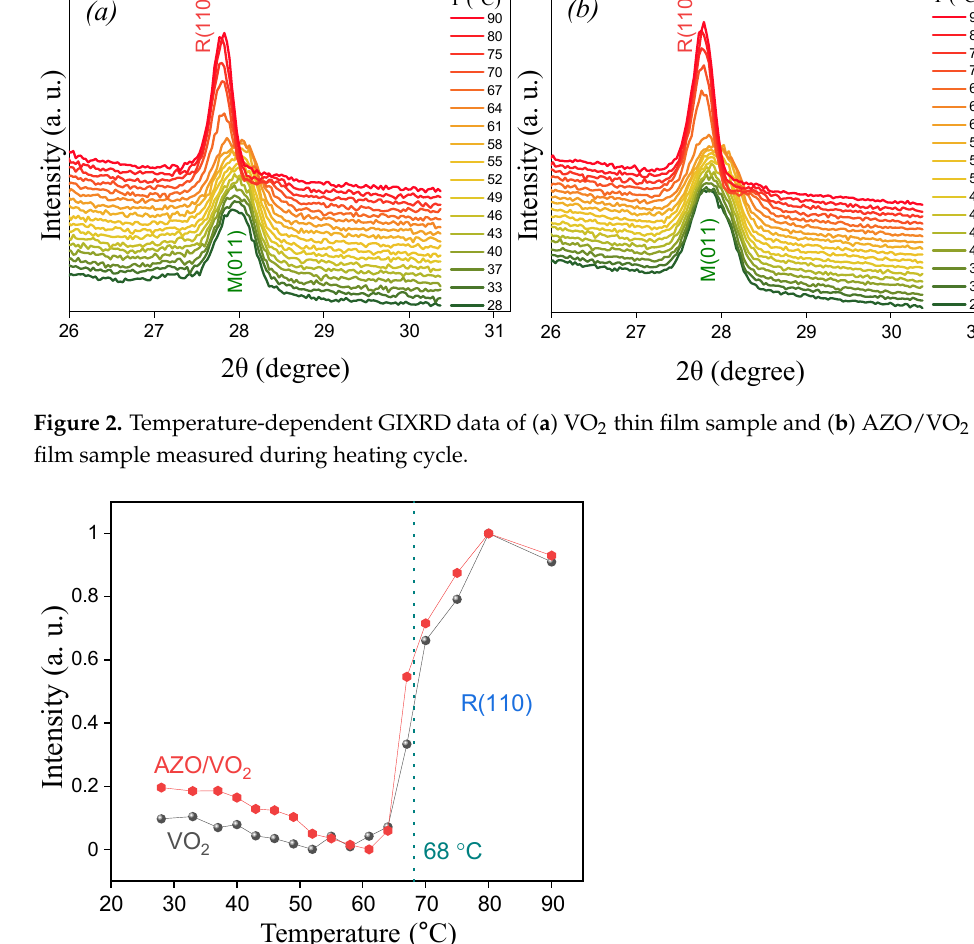
Figure 3. Temperature-dependence intensity variation of R(110) diffraction peak (rutile phase of VO 2 ) for VO 2 and AZO/VO 2 thin film samples.